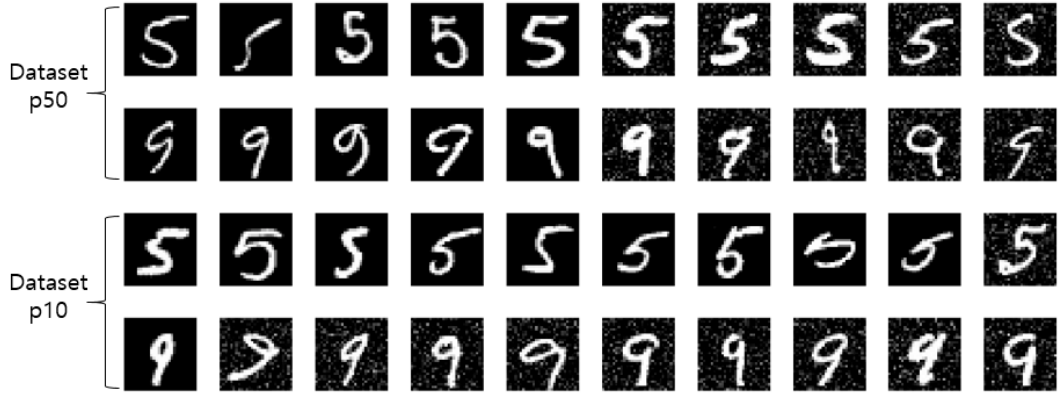
Figure 7. Examples of noisy MNIST data with addition of Gaussian noise.